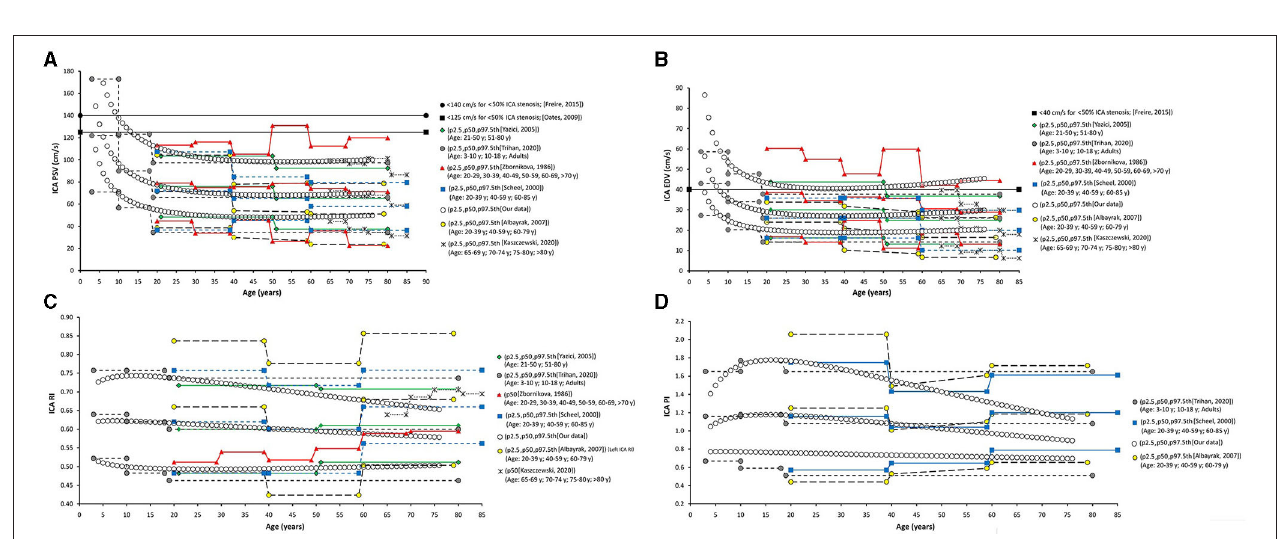
FIGURE 8 | Internal carotid artery. Comparison among curves of PSV (A) , EDV (B) , RI (C) , and PI (D) , obtained in our study (2.5th, 50th, and p97.5th percentiles) and mean values (p50th), and 2.5th (MV-1.96 × SD) and 97.5 (MV + 1.96 × SD) percentiles obtained by other authors when studying groups of subjects of different ages. The fixed cut-off levels used to identify (graduate) levels of arterial stenosis are also